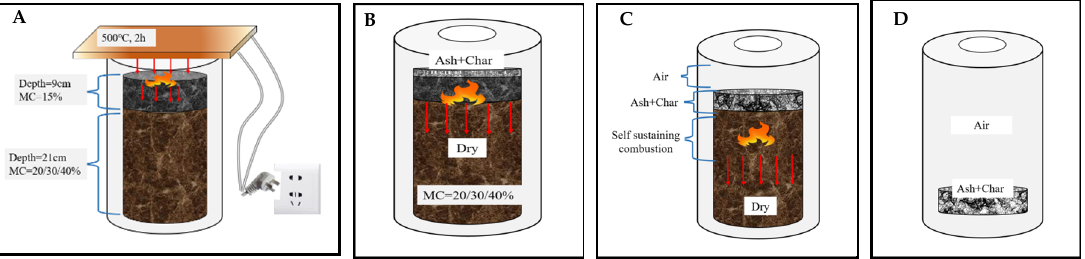
Figure 3. Process of the smoldering samples ( A : Igniting; B : Start self-sustaining combustion; C : Self-sustaining combustion; D : Completely extinguished).